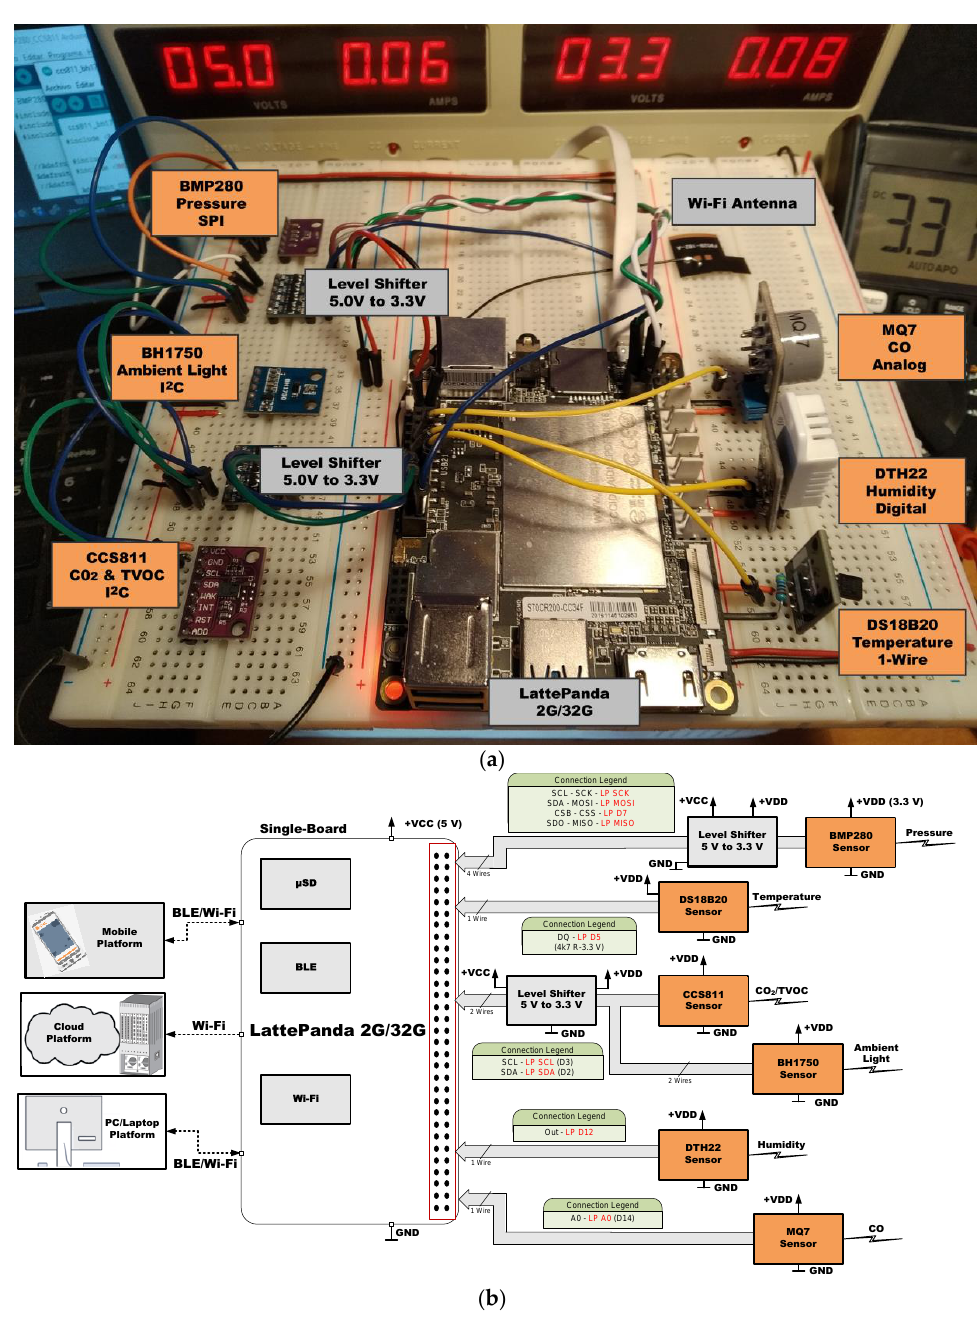
Figure 7. SBC LattePanda 2G/32G in experimental framework ( a ) and hardware connections ( b ) [150].